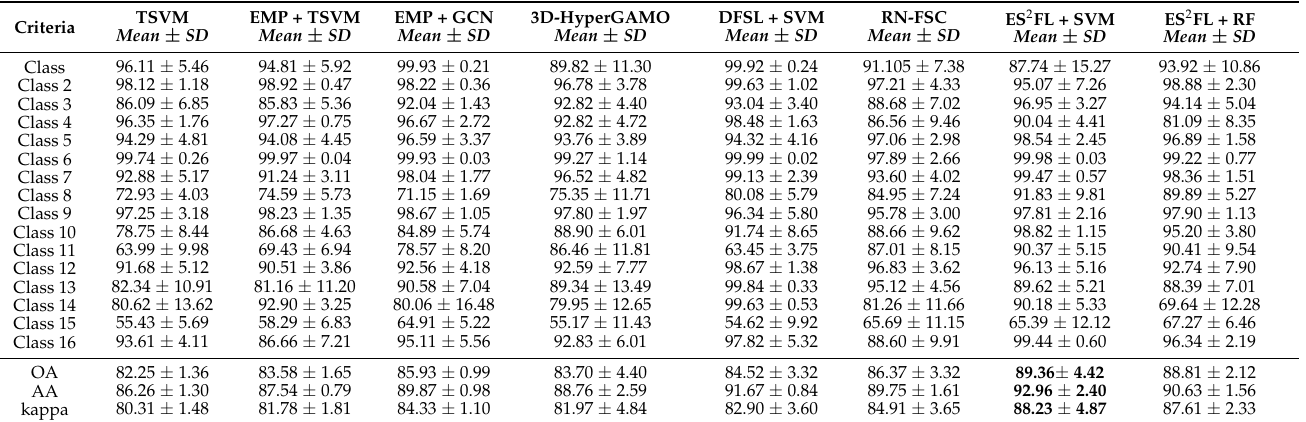
Table 6. The classification results of different methods on the SA data set in the case of small samples. SD denotes the standard deviation of 10 experimental